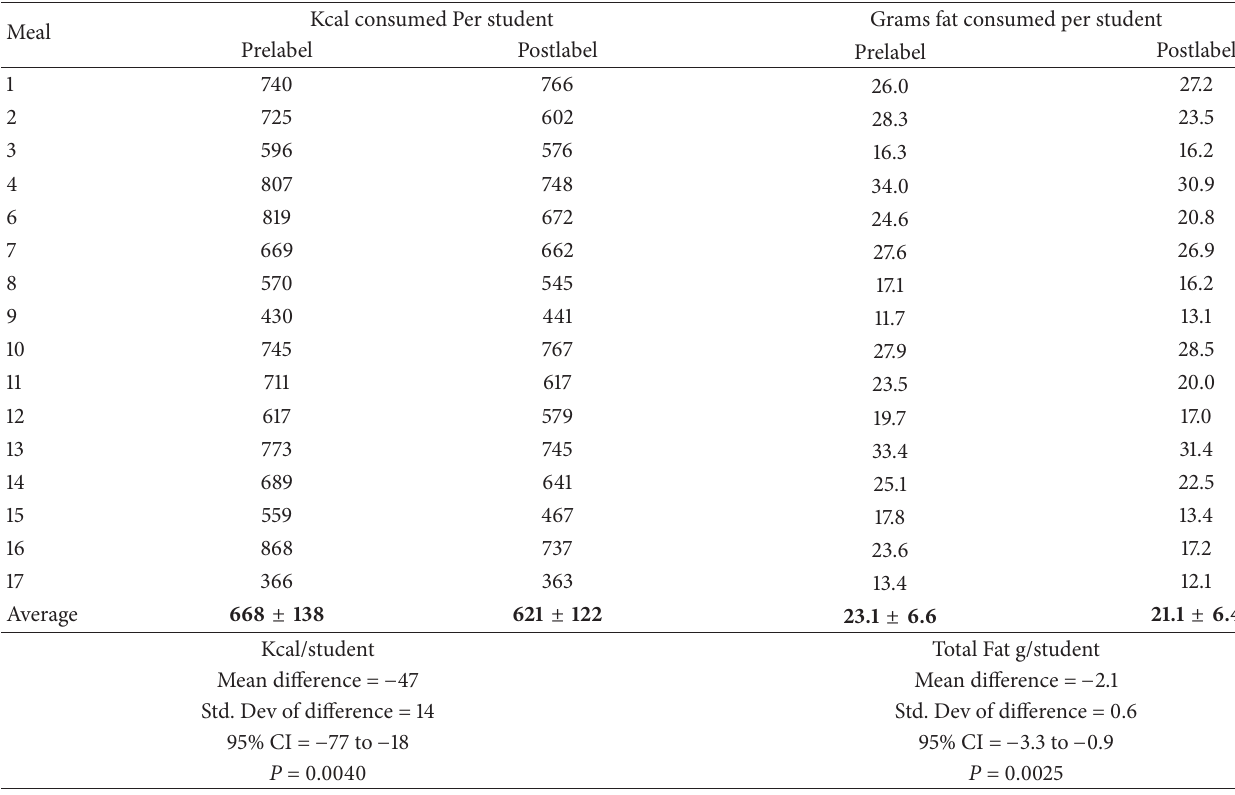
Table 1: Changes in calorie and fat consumption.